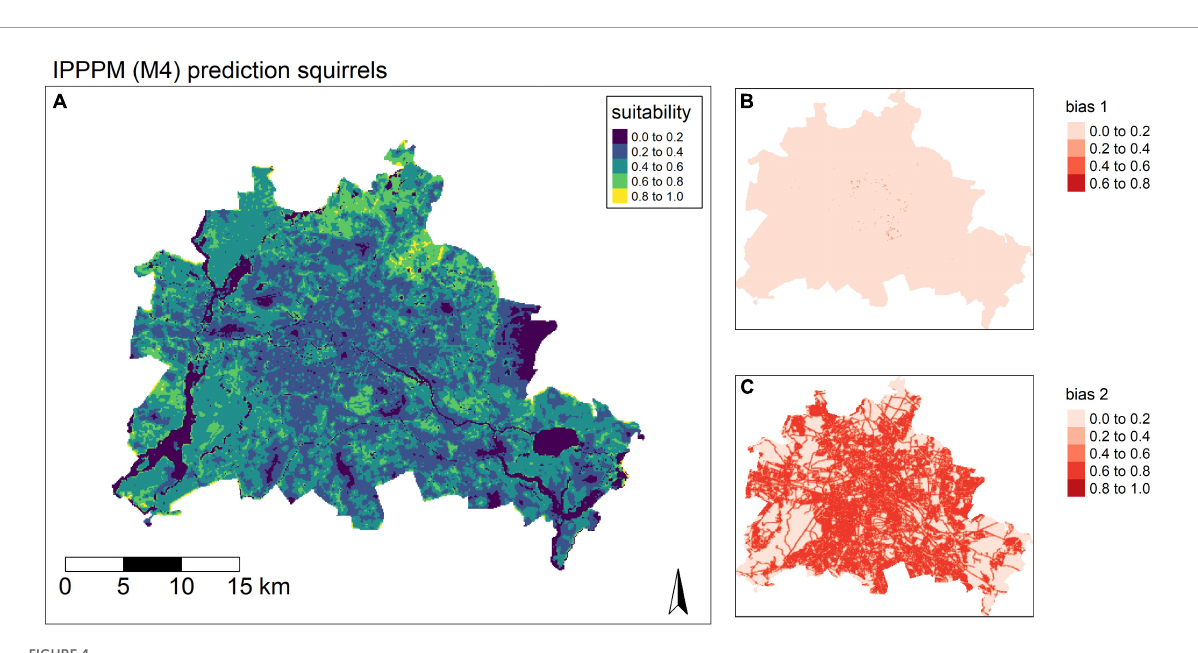
FIGURE4 (A) Reference model (M4): Red squirrel distribution model. Data integration approach using an inhomogeneous Poisson-Point-Process-model and a combined likelihood maximization. (B) Bias correction for semi-structured data set. (C) Bias correction for unstructured data set.